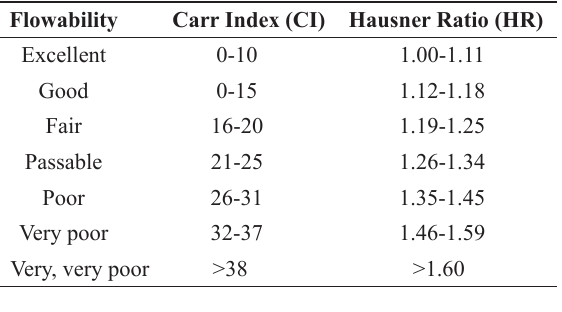
Characterization for Carr index and Hausner ratio (Shishir et al.